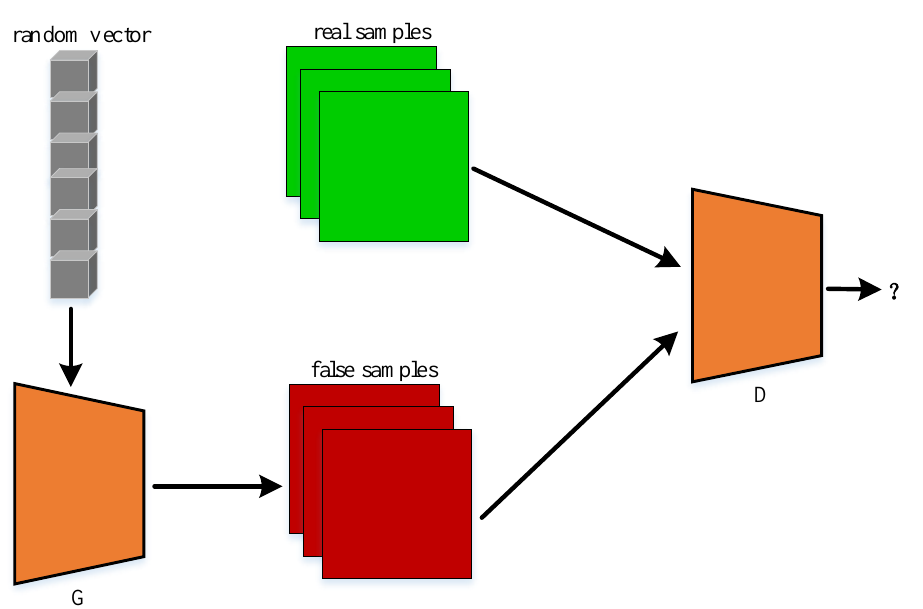
Figure 3. GAN training flow chart. G represents the generator of GAN and D represents the discriminator of GAN. The function of G is to learn the mapping rules of the random noise to the generated data and then obtain the generated image (the false sample). D is used to determine whether a sample is a real sample or a false